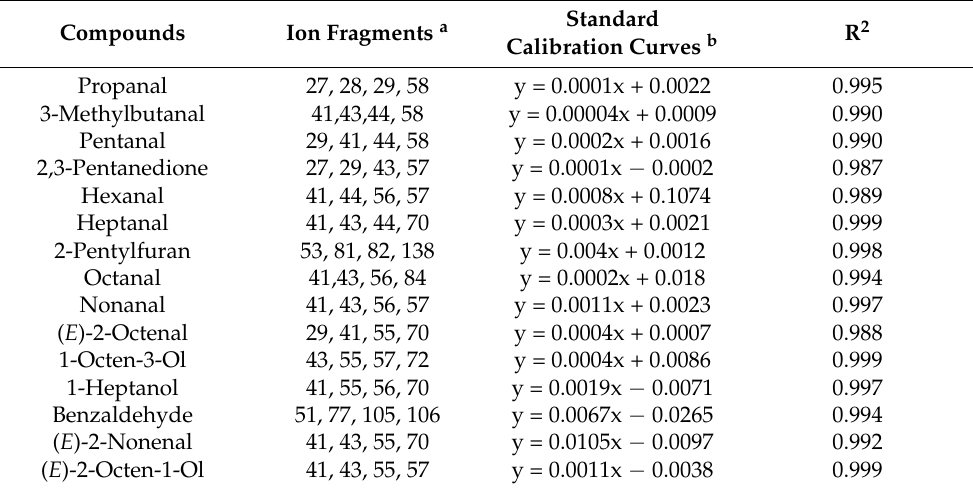
Table 2. Ion fragments and standard calibration curves of aroma compounds (OAVs >1) in the pre- and postrigor roasted mutton.